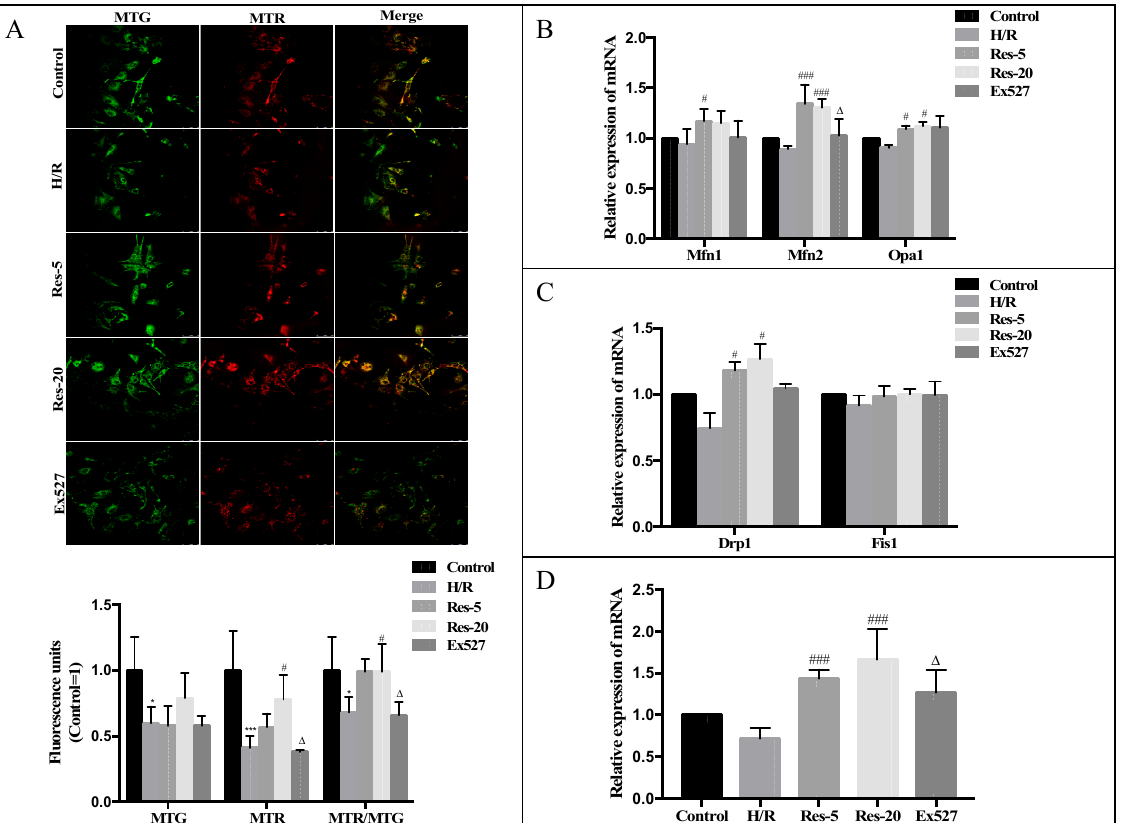
Figure 3. Resveratrol treatment regulates mitochondrial function, fission–fusion and biosynthesis in neonatal rat cardiomyocytes after H/R, while this effect was abrogated by EX527. ( A ) Representative picture of mitochondria probed with MTG and MTR through laser-scanning confocal microscopy. RT-PCR was performed with cardiomyocytes lysate for relative expression of ( B ) Mfn1, Mfn2 and Opa1, ( C ) Drp1 and Fis1, ( D ) PGC-1 α . Figures are representative images of three different samples. Results are expressed as mean ± S.D. * p < 0.05, *** p < 0.001 vs. control group; # p < 0.05, ### p < 0.005 vs. H/R group; ∆ p < 0.05 vs. Res-20 group.